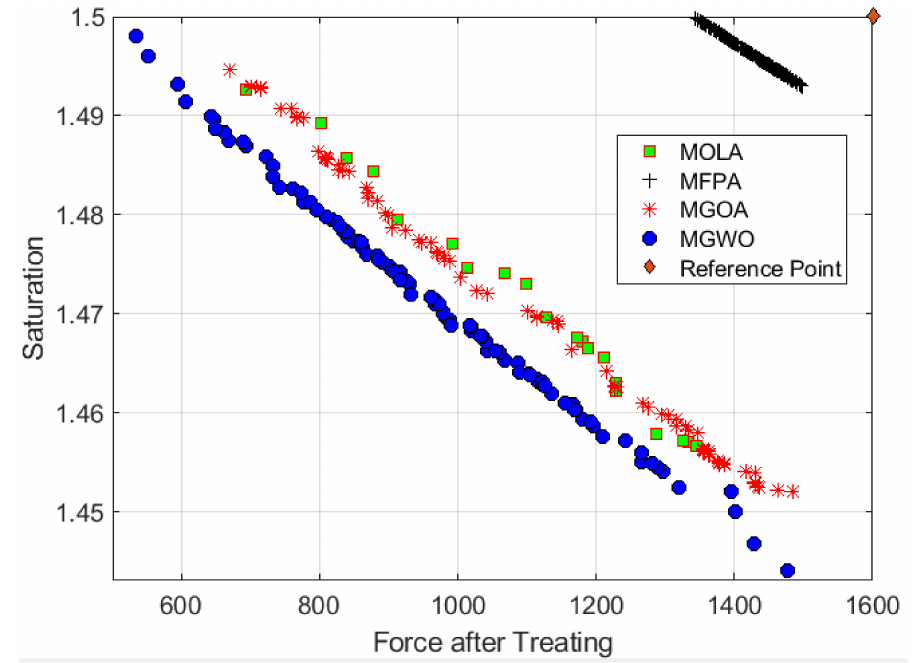
Figure 11. Obtained Pareto fronts of Figure 10 after transfer mapping under third